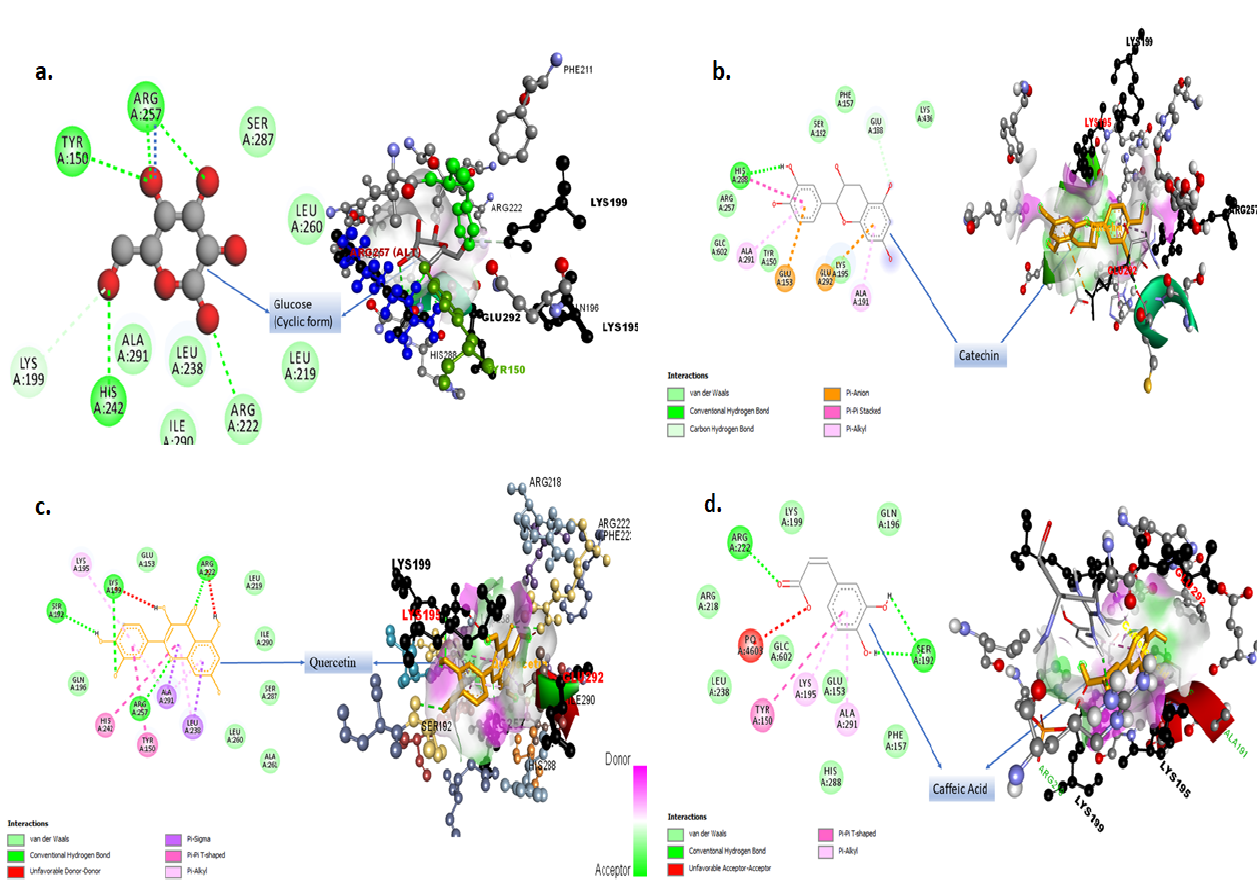
Figure 9. 2D and 3D interaction models of ligands with HSA. Ligands used are ( a ) glucose, ( b ) cat- echin, ( c ) quercetin, and ( d ) caffeic acid.